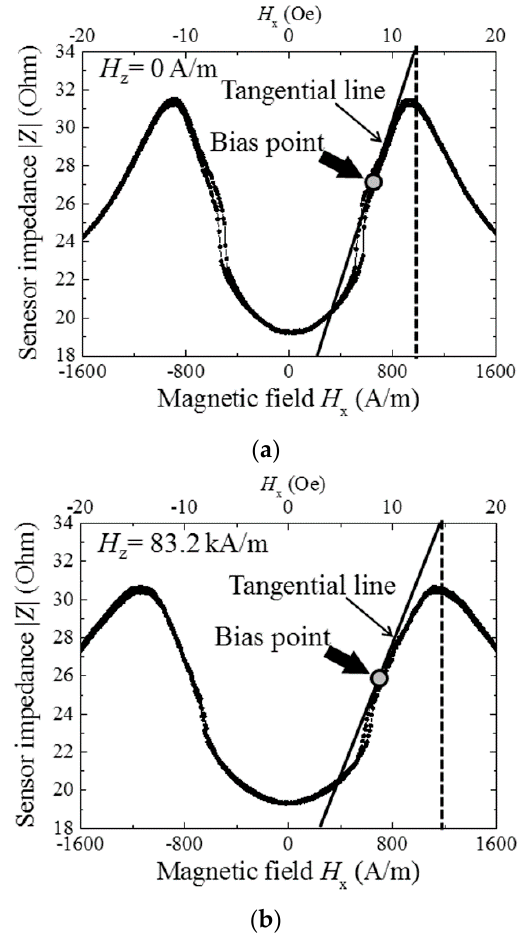
Figure 21. MI-curve and tangential line at bias-point of sensor operation, ( a )The normal field is zero, and ( b )The normal field is 83.2 kA/m [21].